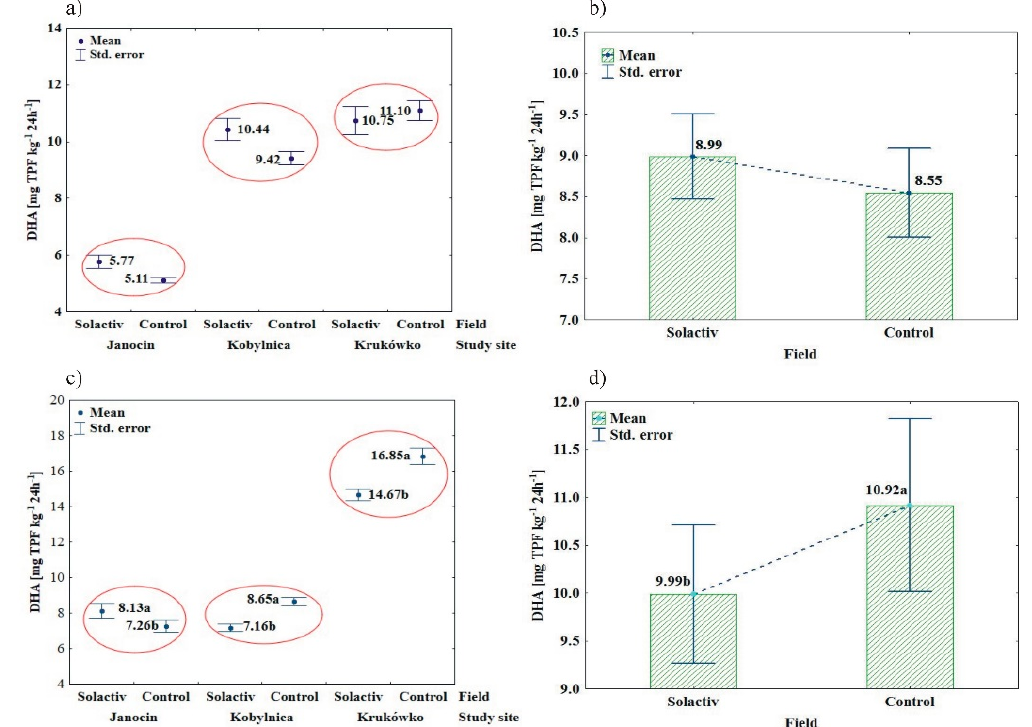
Figure 1. Dehydrogenase activity as a ff ected by the tested conditioner. ( a , b ) I sampling (sampling before the maize was sown, n = 10); ( c , d ) II sampling (after the maize was harvested, n = 10); ( b , d ) the mean for all study sites ( n = 30). Data were analyzed using one-way ANOVA. Mean values for conditioner and control followed by di ff erent letters are significantly di ff erent at p ≤ 0.05 according to the Tukey HSD Test. The lack of letters indicates the lack of significance between means.